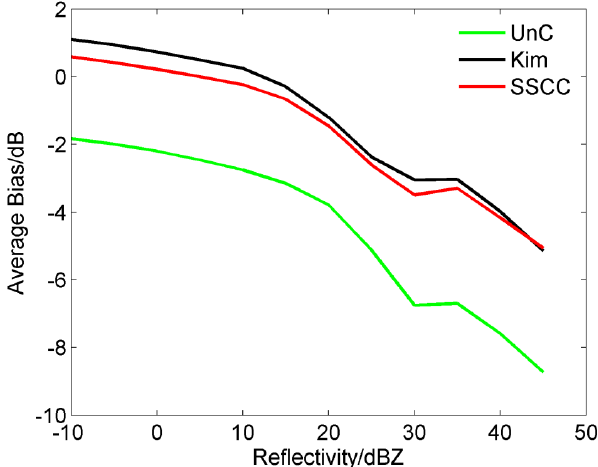
Figure 20. Average bias of reflectivity for the stratiform rain.